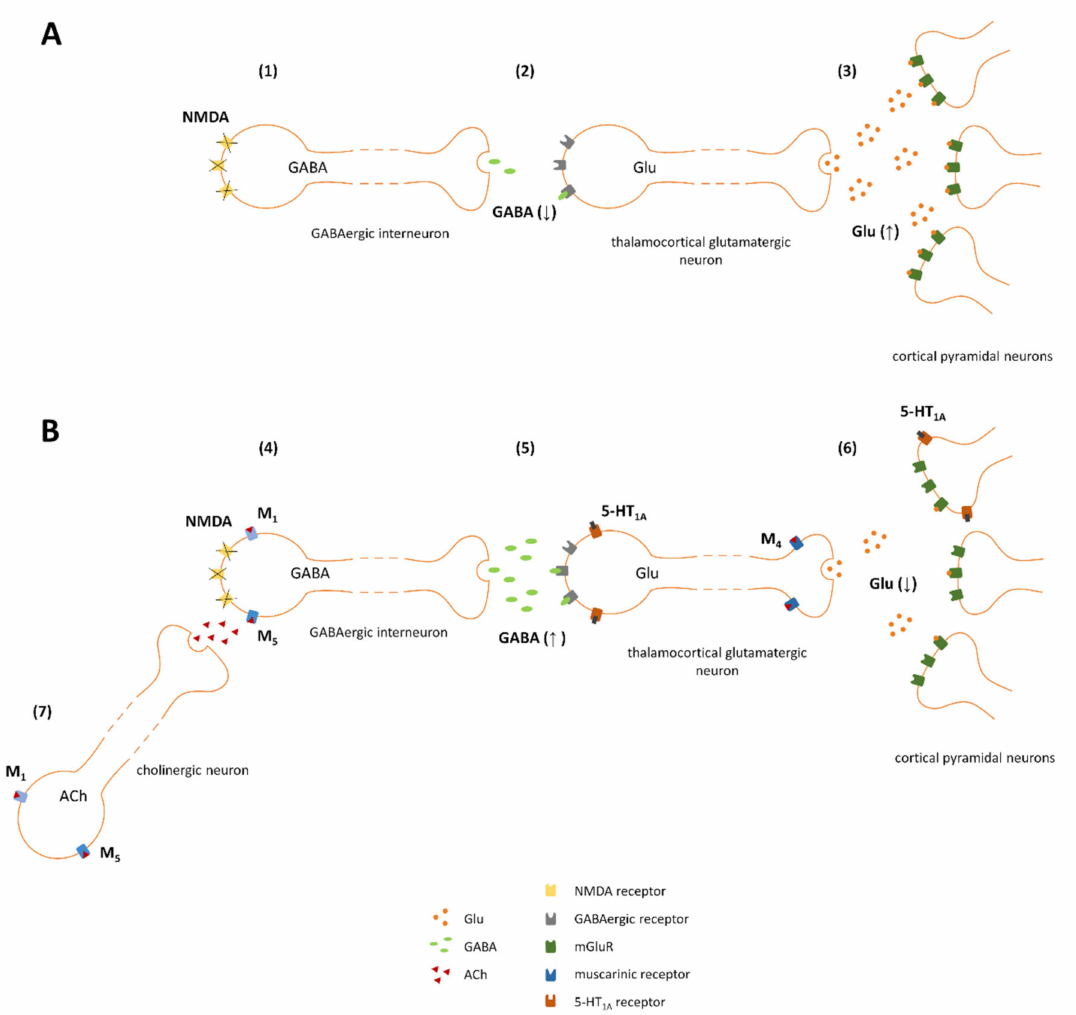
Figure 14. Proposed mechanism of action of investigated combinations (basic scheme adapted from Conn et al. [43]). ( A ) Impaired effect of glutamate on dysfunctional NMDA receptors located on GABAergic neurons (1), results in decreased GABA release (2), disinhibition of subsequent thalamocortical glutamatergic innervation and overactivation of pyramidal glutamatergic neurons in the cortex (3). ( B ) M 1 and M 5 receptors may be expressed on GABAergic neurons (4), and thus, their activation by VU0357017 or VU0238429 counteracts NMDA-related impairments (both M 1 and M 5 receptors are linked to Gq protein and thus are excitatory in nature); additionally, the ligands may activate M 1 or M 5 receptors expressed on cholinergic neurons innervating GABAergic interneurons (7). 5-HT 1A receptors are expressed postsynaptically on glutamatergic neurons in the cortex (5). The receptors are linked to Gi proteins; thus, their activation by F15599 inhibits neuronal activity and counteracts the hyperexcitability observed in individuals with schizophrenia. M 4 receptors are expressed presynaptically on glutamatergic terminals; their stimulation by VU0152100 activates Gi protein, which are inhibitory in nature and leads to the inhibition of glutamate release